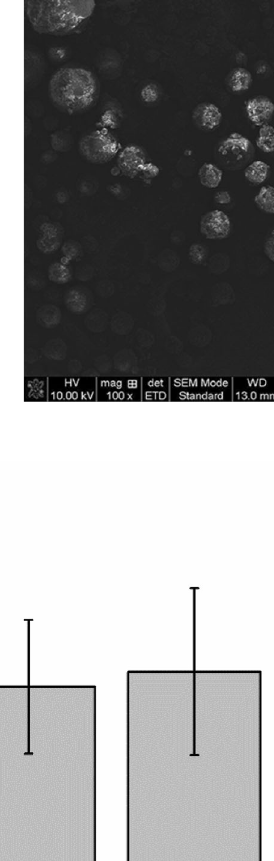
Fig. 2 SEM micrographs of